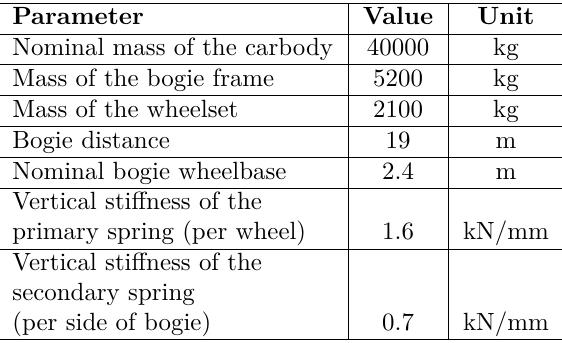
Table 1. Fundamental parameters of the multi-body model of the railway vehicle.